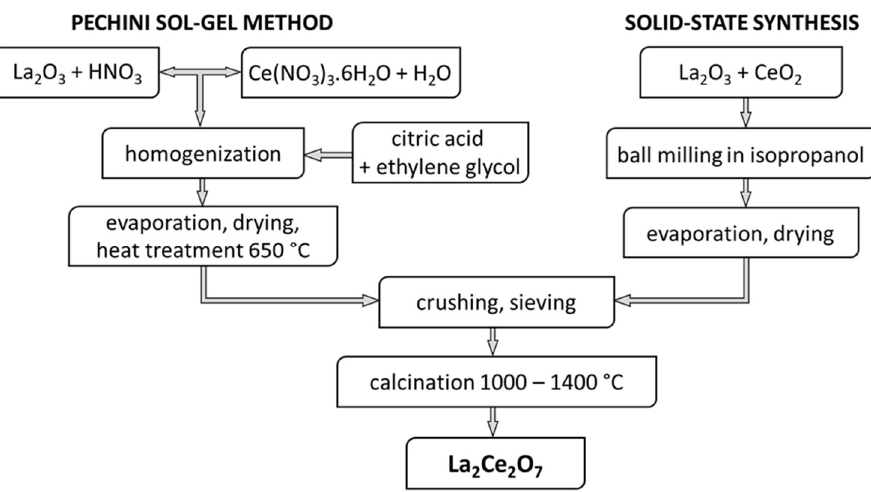
Figure 1. Scheme of obtaining LC powders by Pechini sol-gel method and solid-state